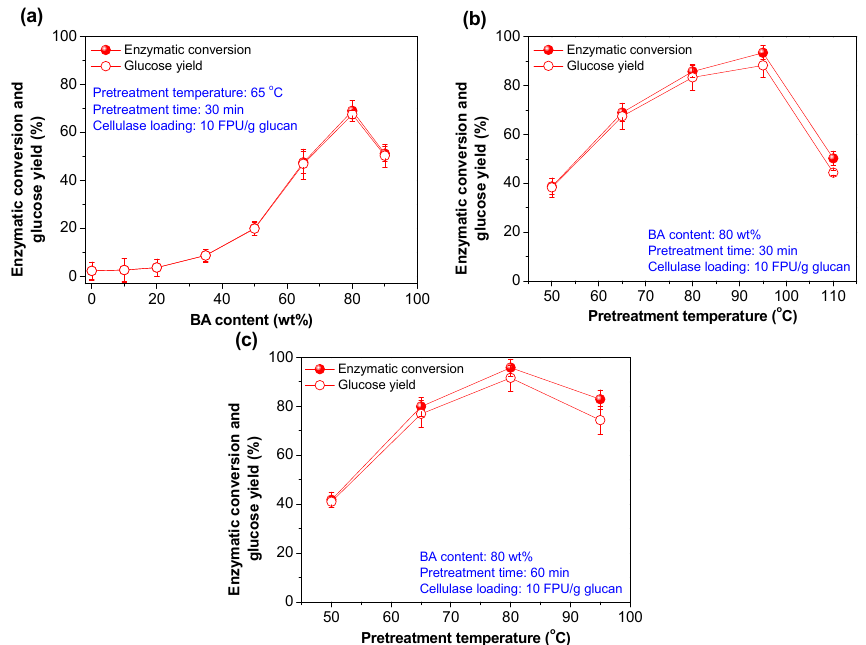
Figure 3. Effects of the pretreatment conditions on the enzymatic hydrolysis efficiency. ( a ) BA content Figure 3. E ff ects of the pretreatment conditions on the enzymatic hydrolysis e ffi ciency. ( a ) BA content effects at 65 °C for 30 min; ( b , c ) temperature effects at a BA content of 80 wt % for ( b ) 30 min and ( c ) e ff ects at 65 ◦ C for 30 min; ( b , c ) temperature e ff ects at a BA content of 80 wt % for ( b ) 30 min and 60 min, respectively. ( c ) 60 min,